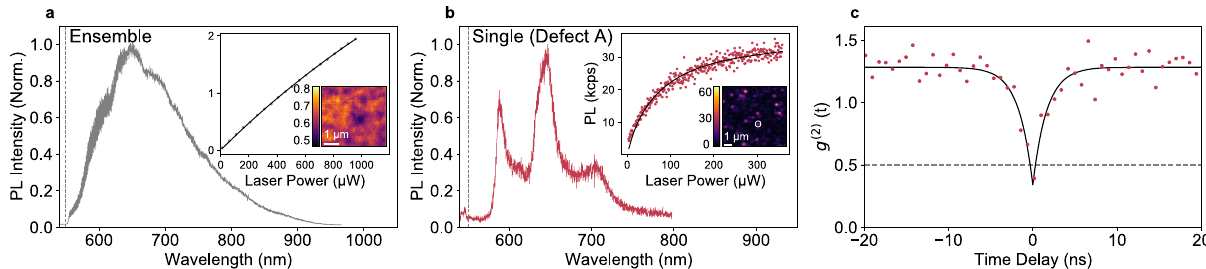
Fig. 1 Optical properties of single and ensemble hBN defects. a Normalised PL spectrum of ensemble defects under 532-nm laser excitation. Dashed vertical line represents the cut-off of a 550-nm long-pass fi lter. Inset: 5 × 5- µ m image map of the integrated-PL intensity and example laser-power dependence of PL counts at a fi xed location. The colour bar scale is in units of million counts per second (Mcps). b Normalised PL spectrum of single defect A under 532-nm laser excitation. Dashed vertical line signi fi es the 550-nm long-pass fi lter. Inset: 10 × 10- µ m image map of the integrated-PL intensity with a white circle around defect A, and the power dependence for defect A, showing optical saturation power ( P sat optical ) = 70(2) µ W and saturated PL intensity (I sat ) = 37,900(300) counts/s. P sat optical re fl ects the power needed to achieve half the saturated PL counts (see Supplementary Fig. 3). The colour bar scale is in units of thousand counts per second (kcps). c Second-order intensity-correlation measurement for defect A at 1.4 P sat optical excitation, solid black curve is a theoretical fi t. The fi tted g (2) (0) = 0.34(3) and optical lifetime of 1.60(1) ns. Background analysis in Supplementary Fig.